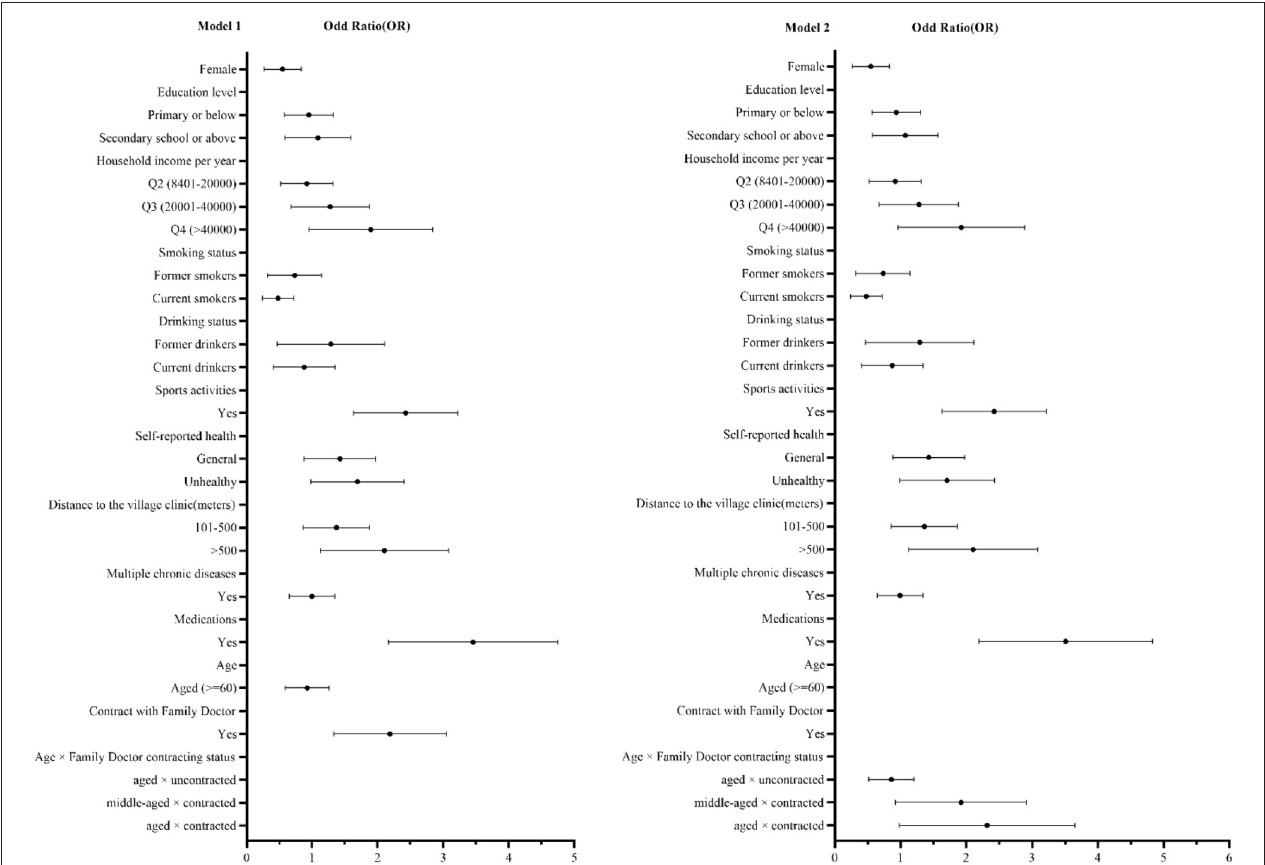
FIGURE 1 | Forest plots of logistic regression analysis of blood pressure management awareness in rural Shandong,